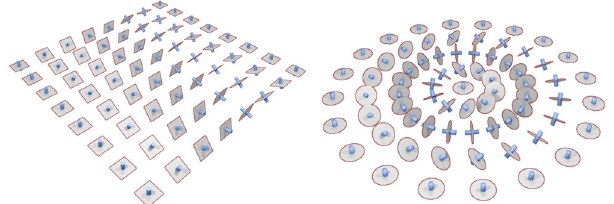
FIG. 6. The splitting T R 3 ≅ L n ⊕ ξ induced by orientational order. Left: A simple helical director profile, corresponding to the ground state of a cholesteric liquid crystal or helimagnet. Right: An idealized, axisymmetric Skyrmion profile, the central portion of which is a standard idealized model of double twist cylinders in blue